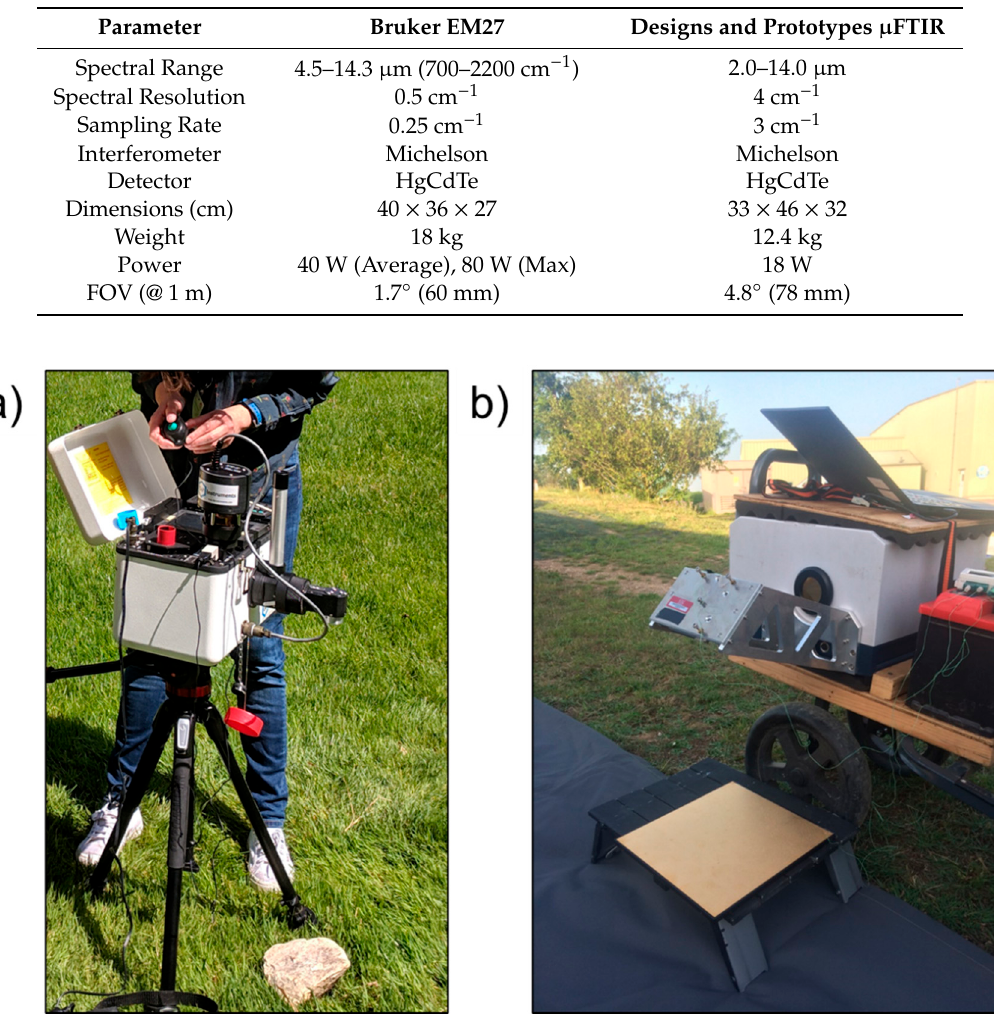
Table 2. Instrument specifications for the portable FTIR spectrometers deployed herein, namely a Bruker EM27 FTIR spectrometer and the Designs and Prototypes μ FTIR [31,40,60]. Parameter